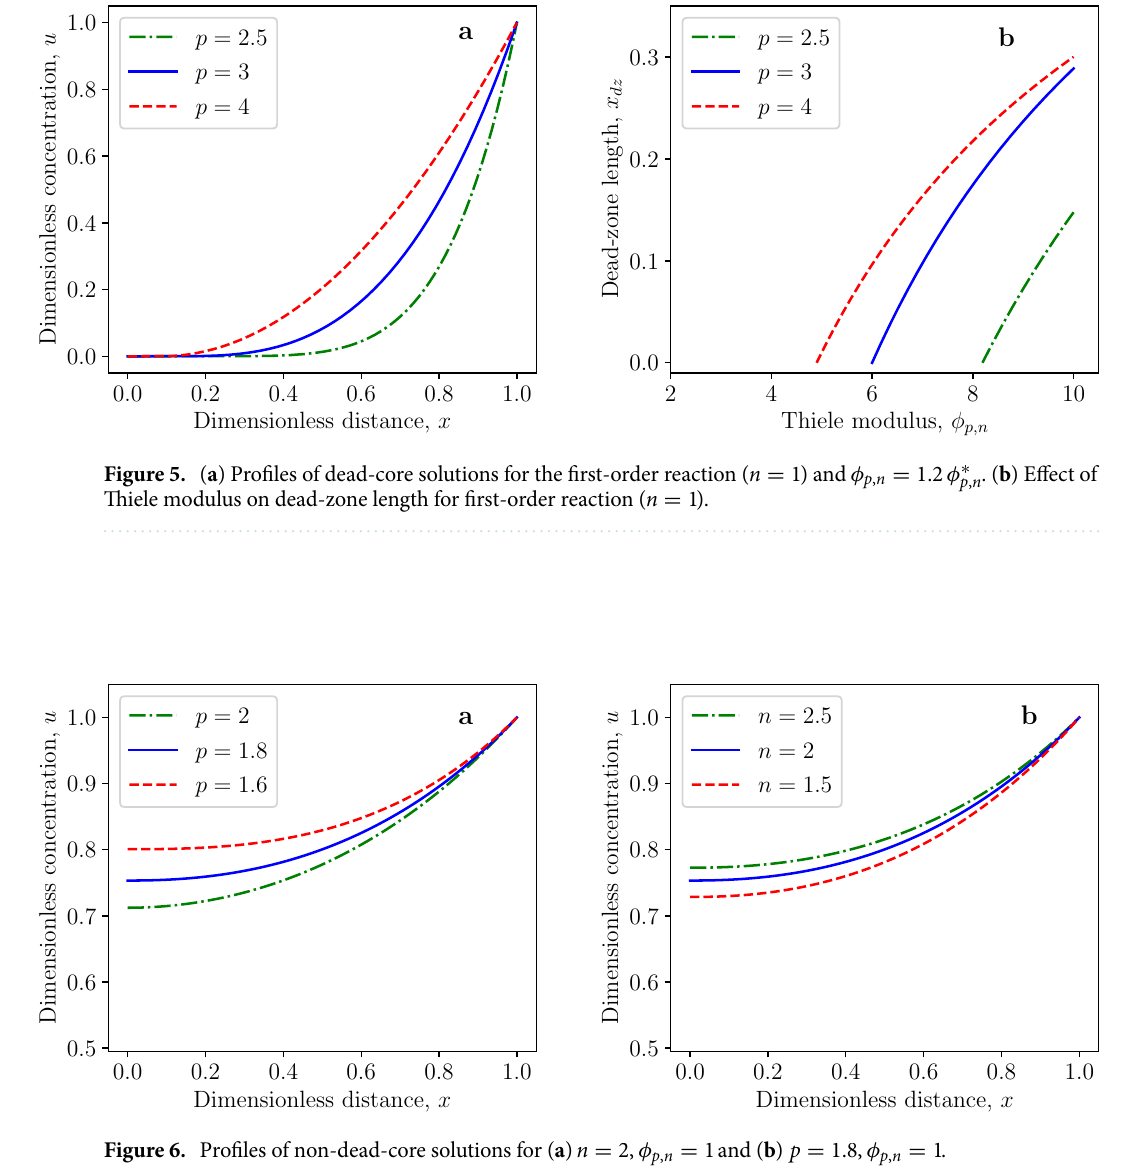
Figure 6. Profiles of non-dead-core solutions for ( a ) n